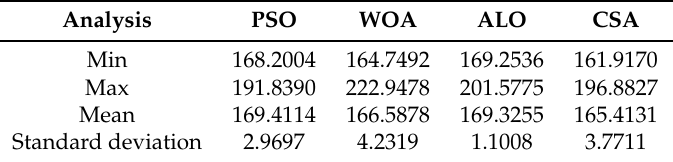
Table 8. Results of real power loss P loss (MW) for Tunisian 86-bus system.